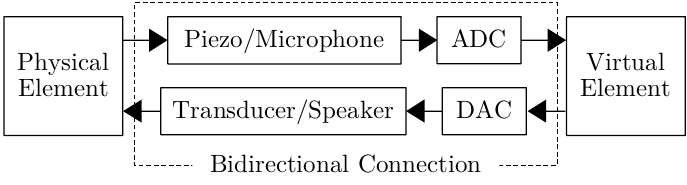
Figure 11. Bidirectional connection between virtual and physical elements of a hybrid instrument.